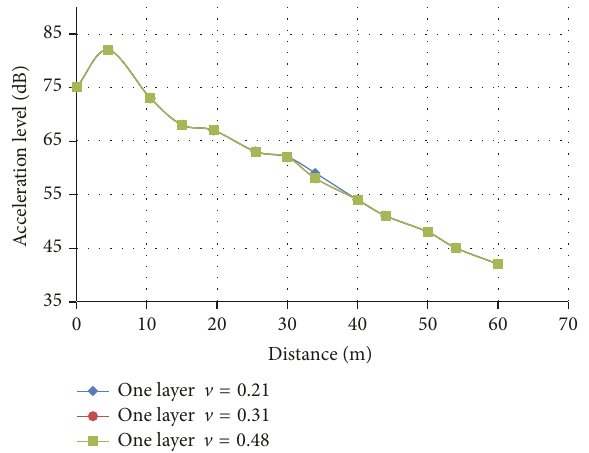
Figure 15: The comparison of acceleration level among cases 1 , 4 , and 5 in Scheme 1 .